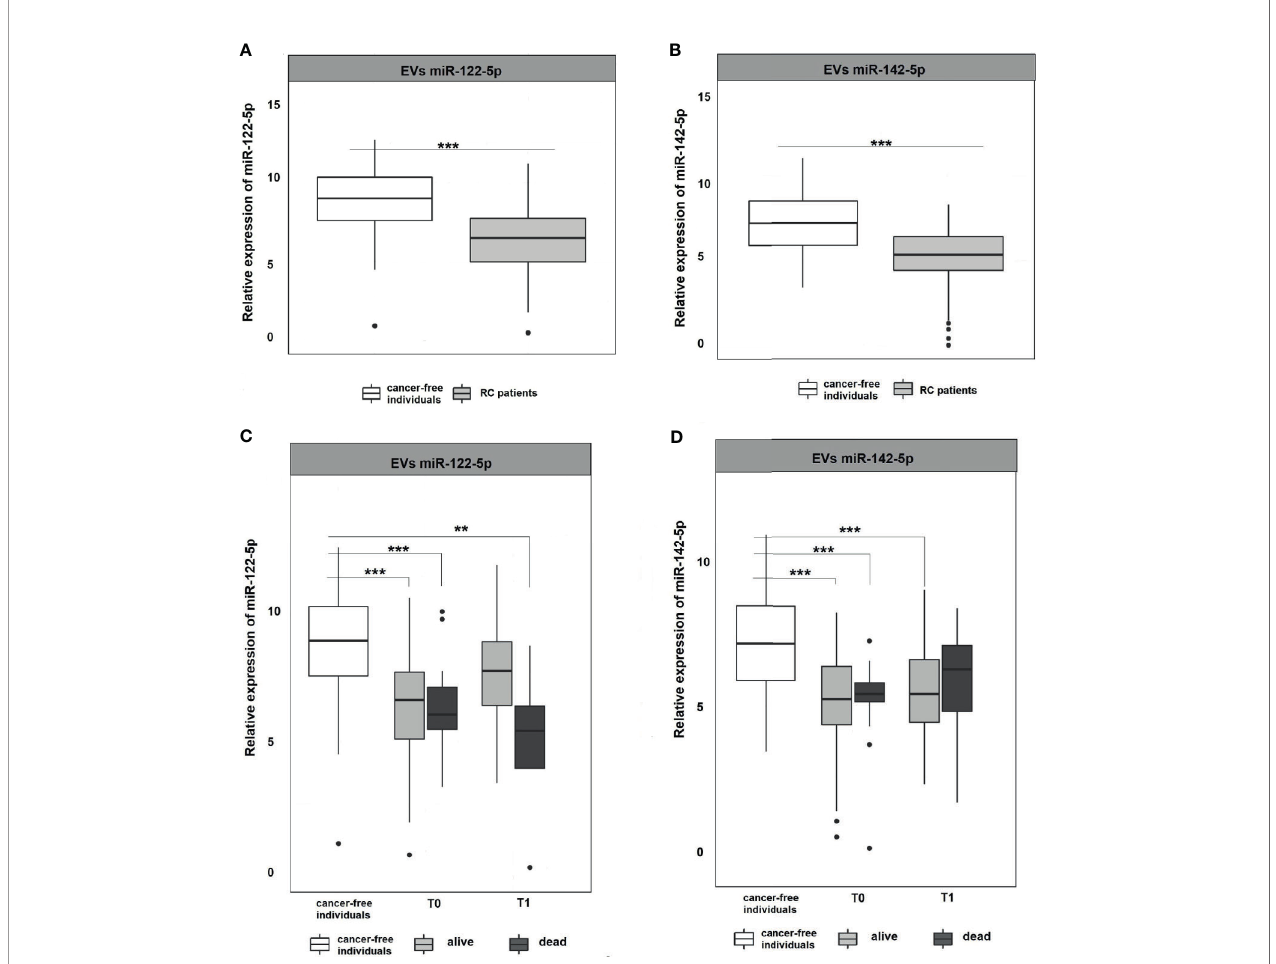
FIGURE 3 | Expression analysis of miR-122-5p and miR-142-5p in EVs. (A, B) Expression levels of miR-122-5p and miR-142-5p were signi fi cantly lower in plasma EVs of RC patients compared to EVs of cancer-free individuals (for all p <0.001). (C, D) A year from the diagnosis (2 nd sampling, T1), a signi fi cant difference was observed between patients that do not respond a year after diagnosis and cancer-free individuals for miR-122-5p (4.9-fold change, p=0.007). This trend was not observed for miR-142-5p. *p ≤ 0.05, **p ≤ 0.01, ***p ≤